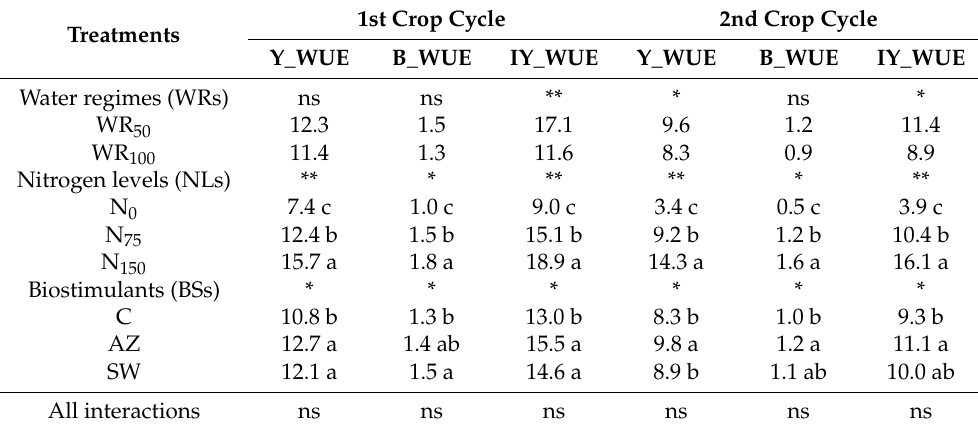
ns, *, ** indicate non-significant or significant F-test at p < 0.05 and p < 0.01, respectively. Different letters indicate significantly different values according to the SNK test ( p = 0.05).